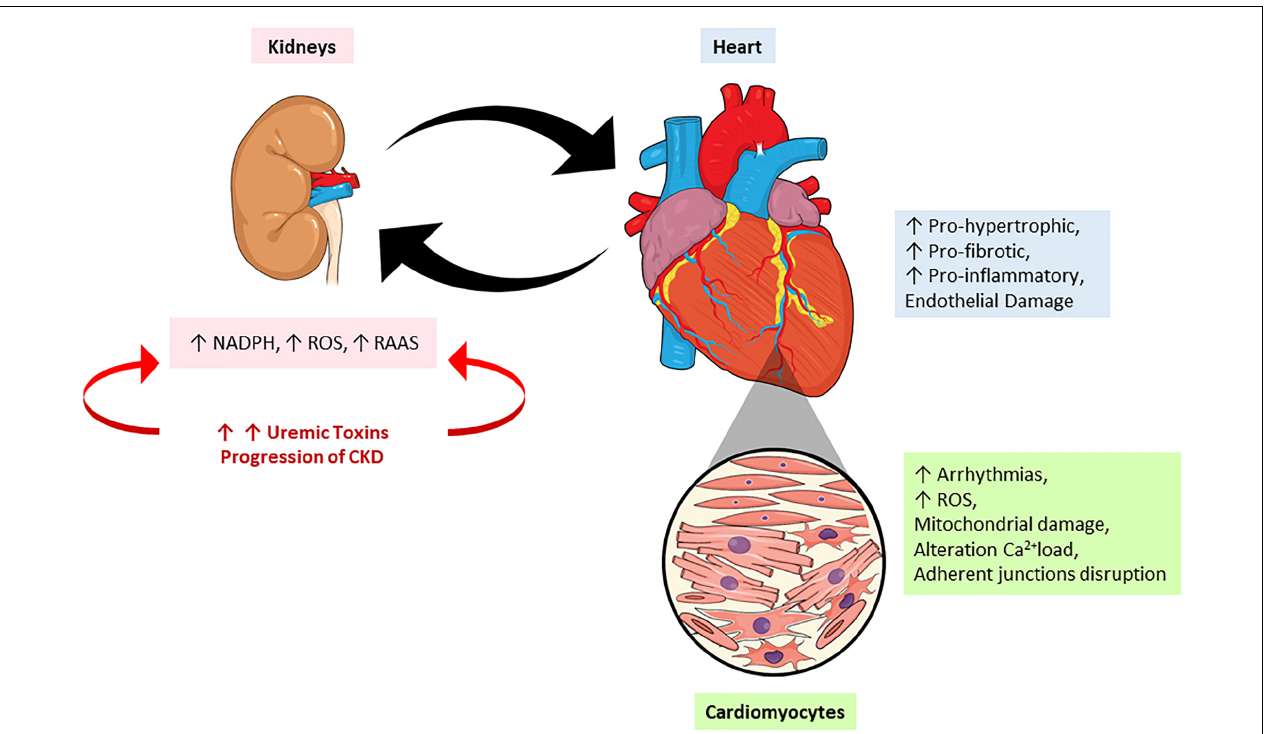
FIGURE 3 | The crosstalk between heart and kidney: contribution of uremic toxins. During the progression of renal lesion there is increase in the circulatory levels of uremic toxins accompanied by an increase on renin-angiotensin-aldosterone system (RAAS) activity and reactive oxygen species (ROS). On the other hand, the heart responds to kidney injury signaling a pro-oxidant, pro-inflammatory effects leading to mitochondrial damage, alterations in calcium loading, arrhythmias and cardiac remodeling. NADPH, nicotinamide adenine dinucleotide phosphate hydrogen; ROS, reactive oxygen species; RAAS, renin-angiotensin-aldosterone